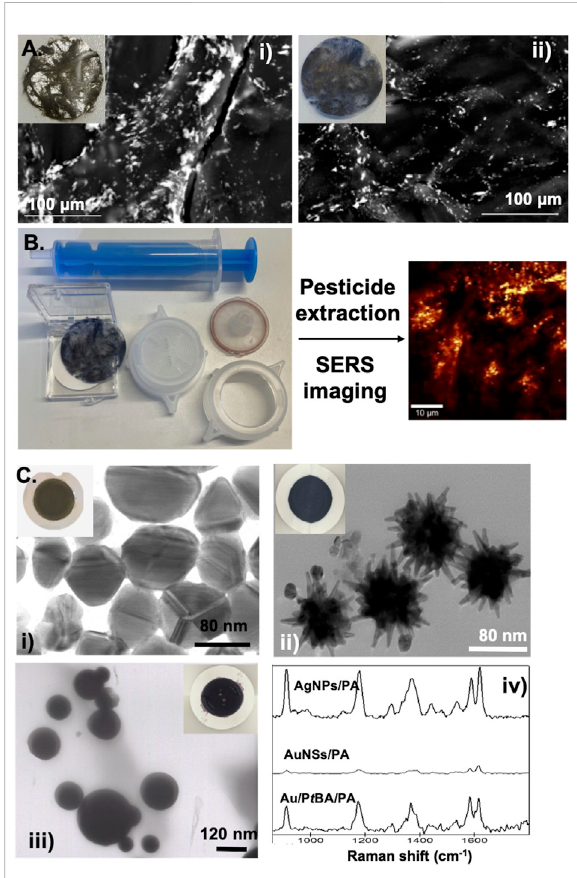
FIGURE 7 (A) SEM images of Ag/LCP (i) and Au/LCP (ii)